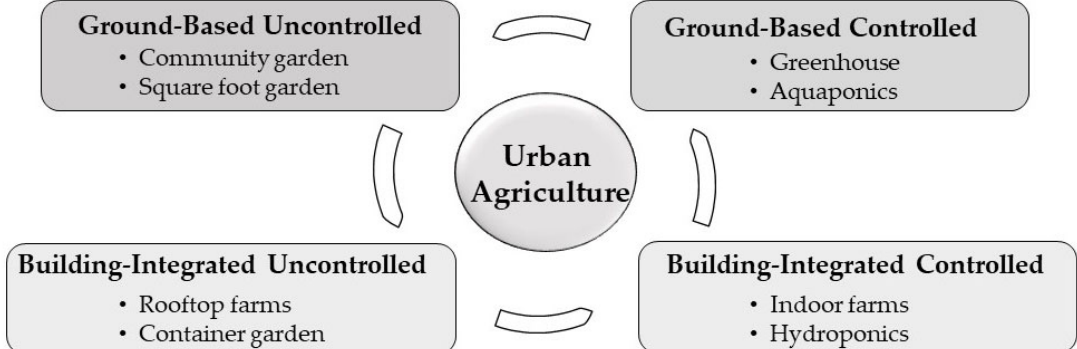
Figure 1. Classification of urban agriculture according to O’Sullivan et al.